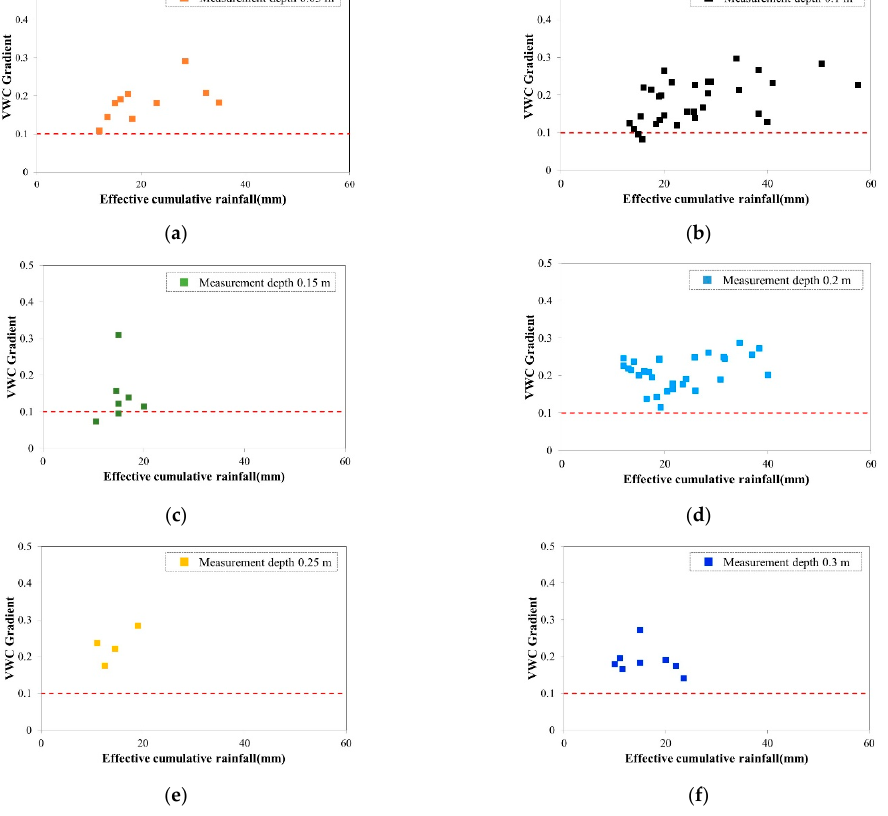
Figure 4. VWC at different measurement depths: ( a ) 0.05 m; ( b ) 0.1 m; ( c ) 0.15 m; ( d ) 0.2 m; ( e ) 0.25 m; ( f ) 0.3 m.